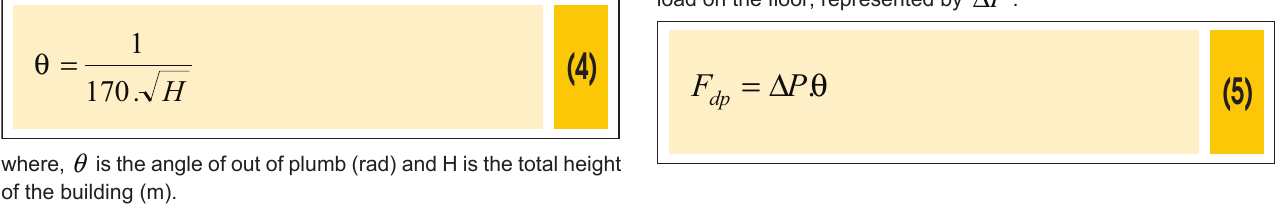
Table 1 – Values o f the areas of influence of the slabs on the walls and lintels and their respective loads